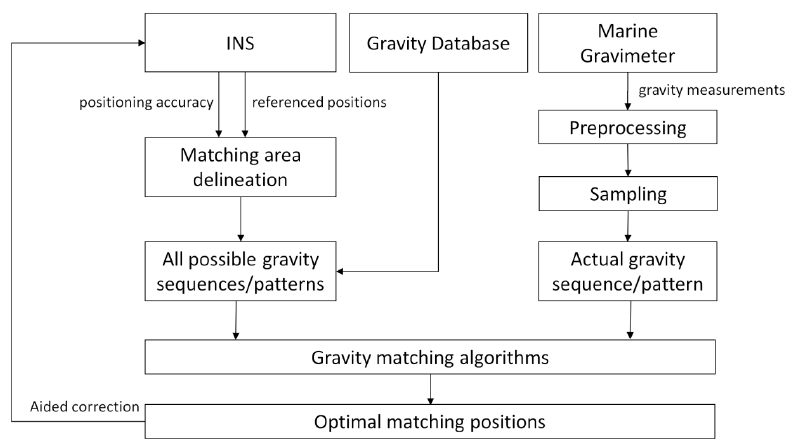
Figure 1. The flowchart of gravity matching aided navigation (GMAN).